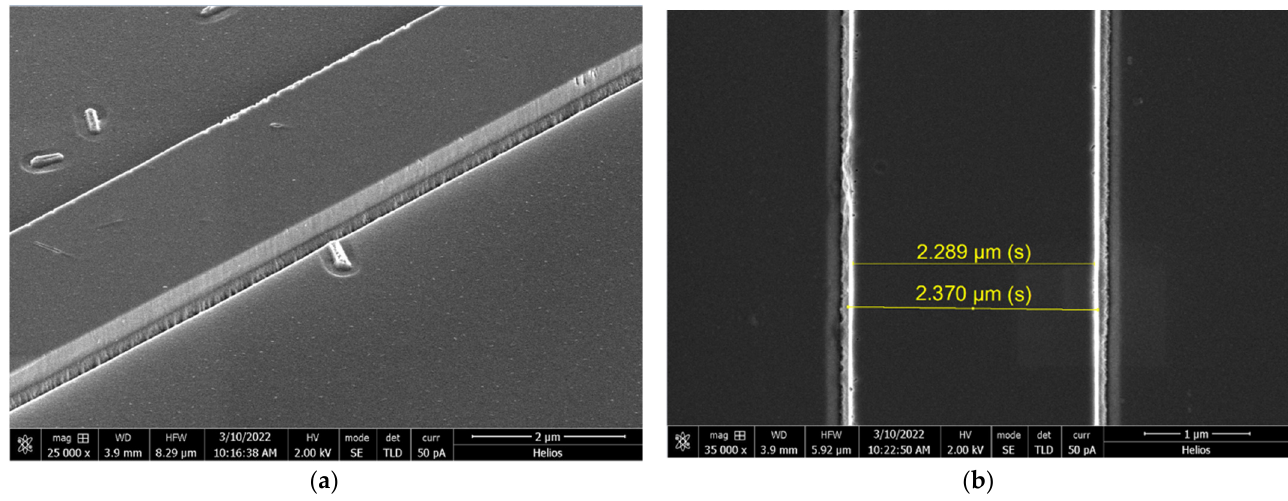
Figure 5. SEM images prepared for layer doped with Rhodamine 6G after etching (CHF 3 -50, Ar-5, 0.3 Pa, 600 W, 165 V, oil, 26 °C, 200 s; the depth of etching was 350 nm): ( a ) etched layer, side view; ( b ) the etched layer, top view, and the marked scale correspond to the distance between the two boundaries of the waveguide.